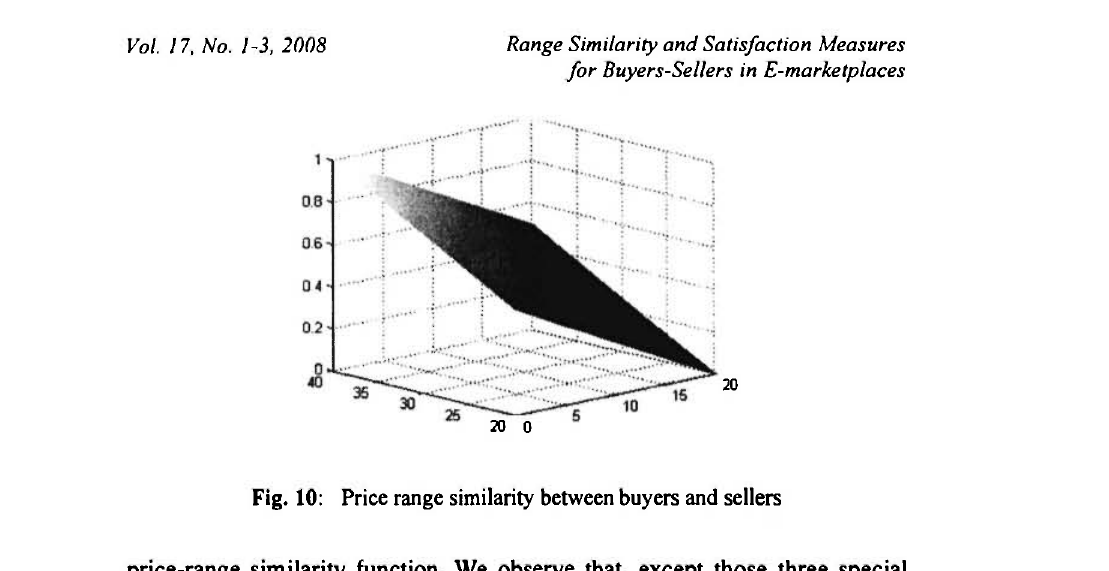
Fig. 10: Price range similarity between buyers and